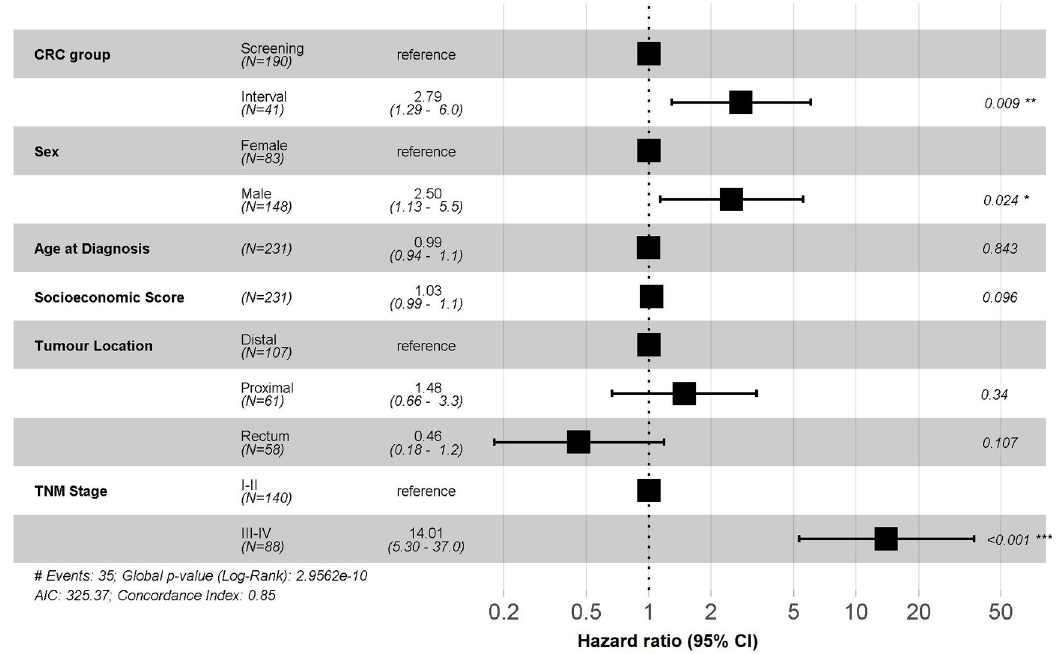
Fig 3. Multivariate analyses for colorectal cancer mortality in FIT participants. a Hazard ratios adjusted by the variables shown in this figure. CRC: colorectal cancer.